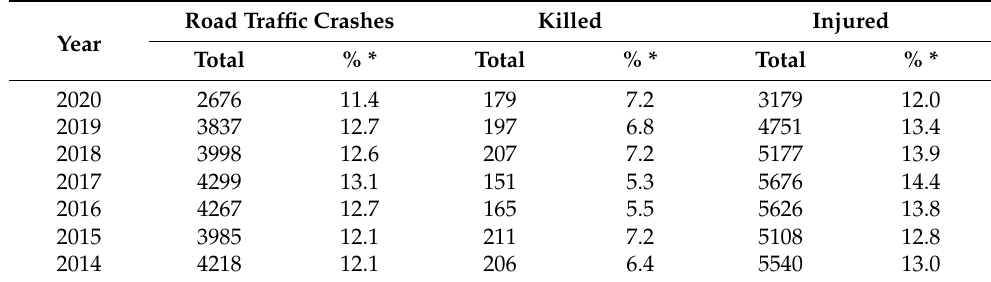
Table 1. Rear-end collisions in